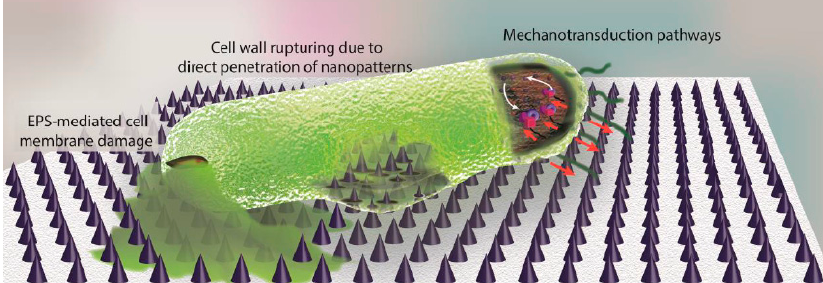
Figure 3. Bacteria killing mechanism of nanopatterned surfaces.